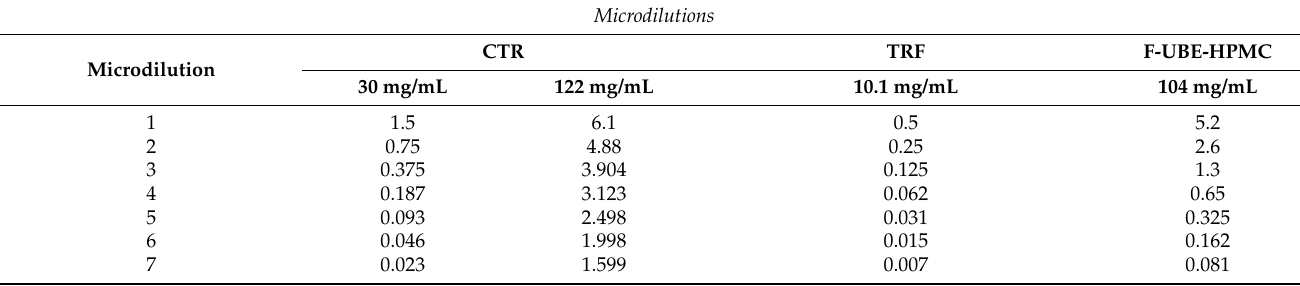
Table 2. Antibacterial and antifungal activity of UBE-loaded mucoadhesive oral patches.